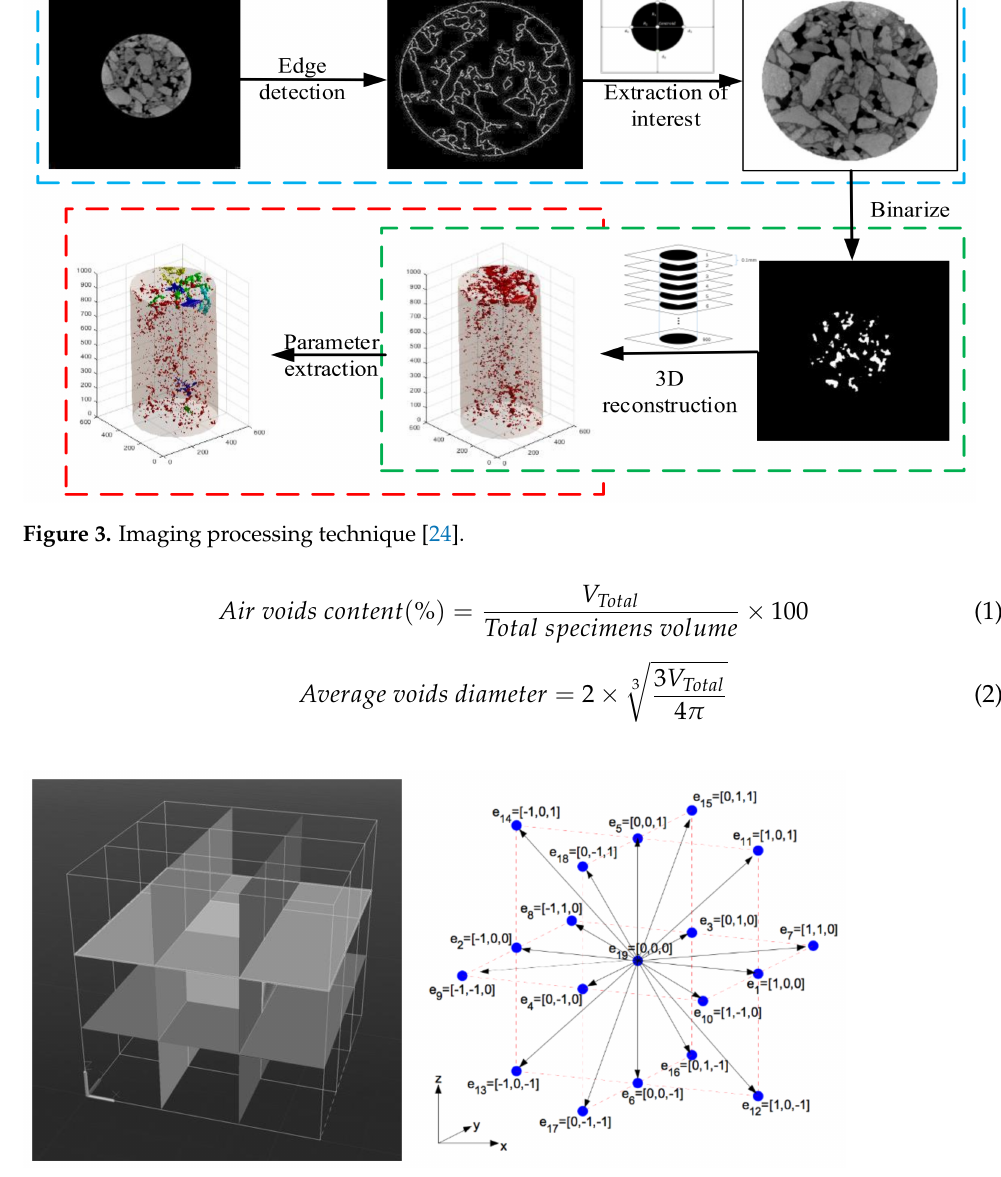
Figure 4. Principle of the three-dimensional 26-neighborhood division of connected